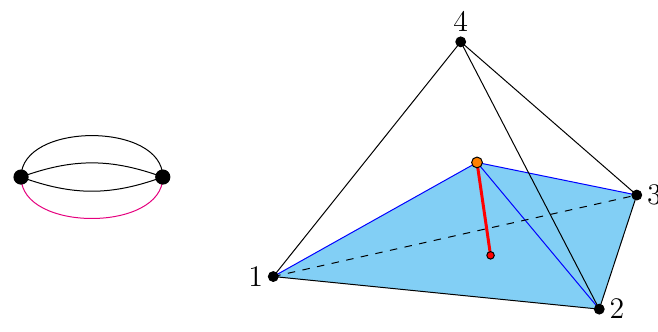
Figure 5 . Cube C T and sector D T for T = e 4 in the 4-edge-banana graph B 4 . Note how the fiber over [1 : 1 : 1 : 0] ∈ C , consisting of three open cones, equals the union of the three sectors for T B 3 = B 4 /e 4 in figure 1.